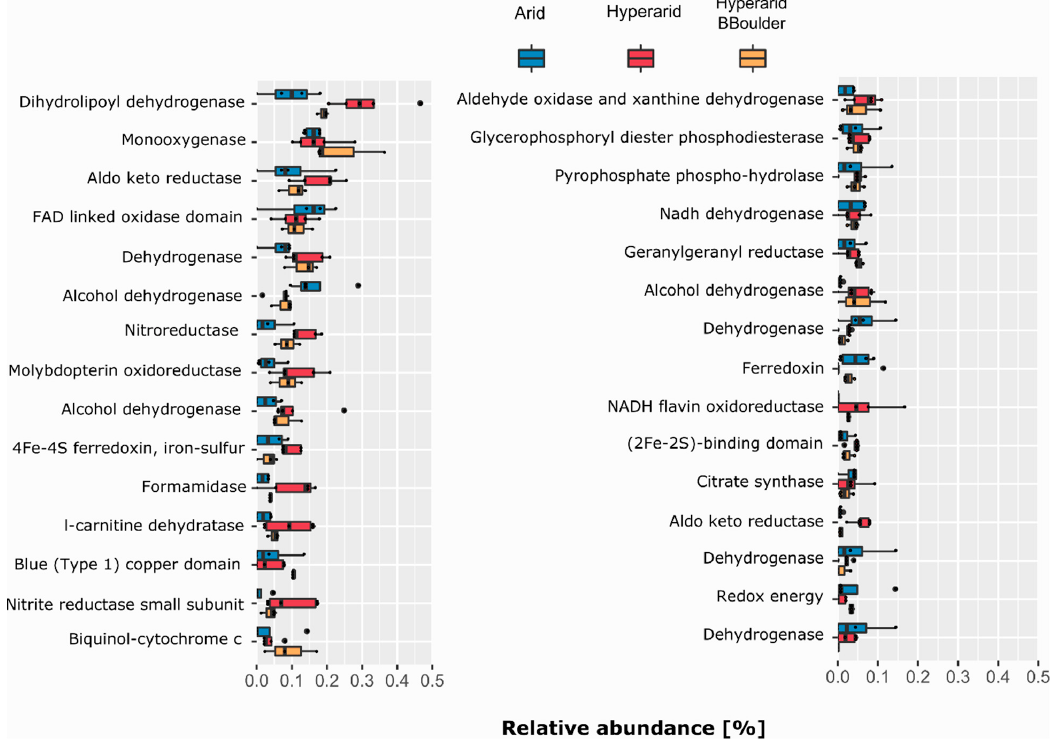
Figure 3. COGs related to energy production co-occurring with MGEs. The 30 most abundant COGs co-occurring with MGEs were selected. n = 4, 5 and 3 at the Arid, Hyperarid and Hyperarid-Boulder sites, respectively. COG numbers can be found in the supplementary material.